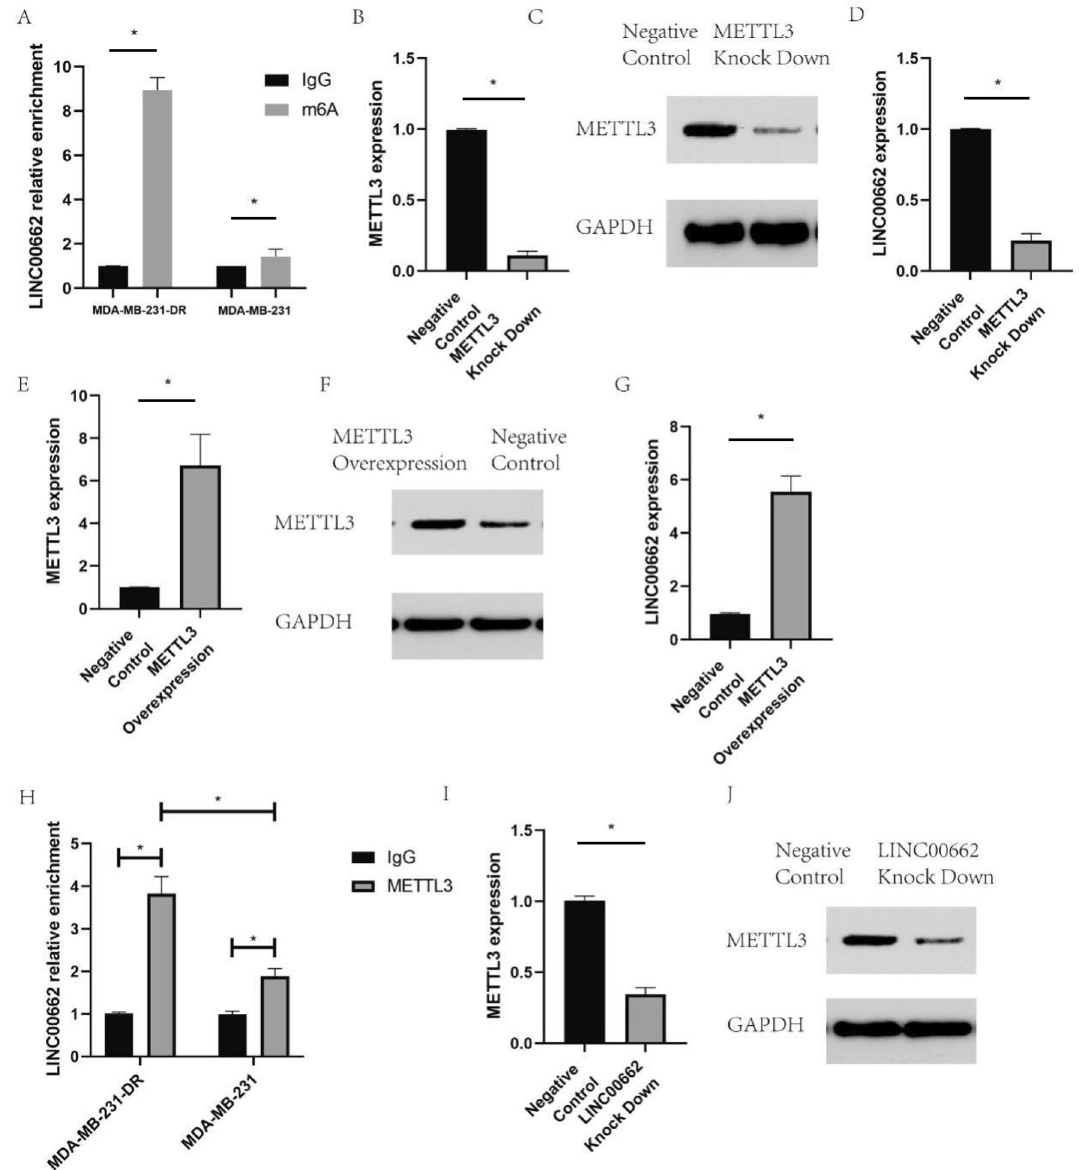
Figure 3. LINC00662 was significantly enriched by m6A antibody and the expression of LINC00662 was downregulated with METTL3 knockdown and upregulated with METTL3 overexpression. RIP assay showed that METTL3 could bind to LINC00662 and LINC00662 knock down also affected METTL3 expression. ( A ) Me-RIP to evaluate the enrichment of LINC00662 by m6A antibody in MDA-MB-231 and MDA-MB-231-DR; ( B , C ) METTL3 knock down efficiency in MDA-MB-231-DR by qRT-PCR and western blot; ( D ) LINC00662 expression in METTL3 knocked down MDA-MB-231-DR; ( E , F ) METTL3 overexpression efficiency in MDA- MB-231-DR by qRT-PCR and western blot; ( G ) LINC00662 expression in METTL3 overexpressed MDA-MB- 231-DR; ( H ) RIP assay to evaluate the interaction between METTL3 and LINC00662. ( I , J ) METTL3 expression in LINC00662 knocked down MDA-MB-231-DR by qRT-PCR and western